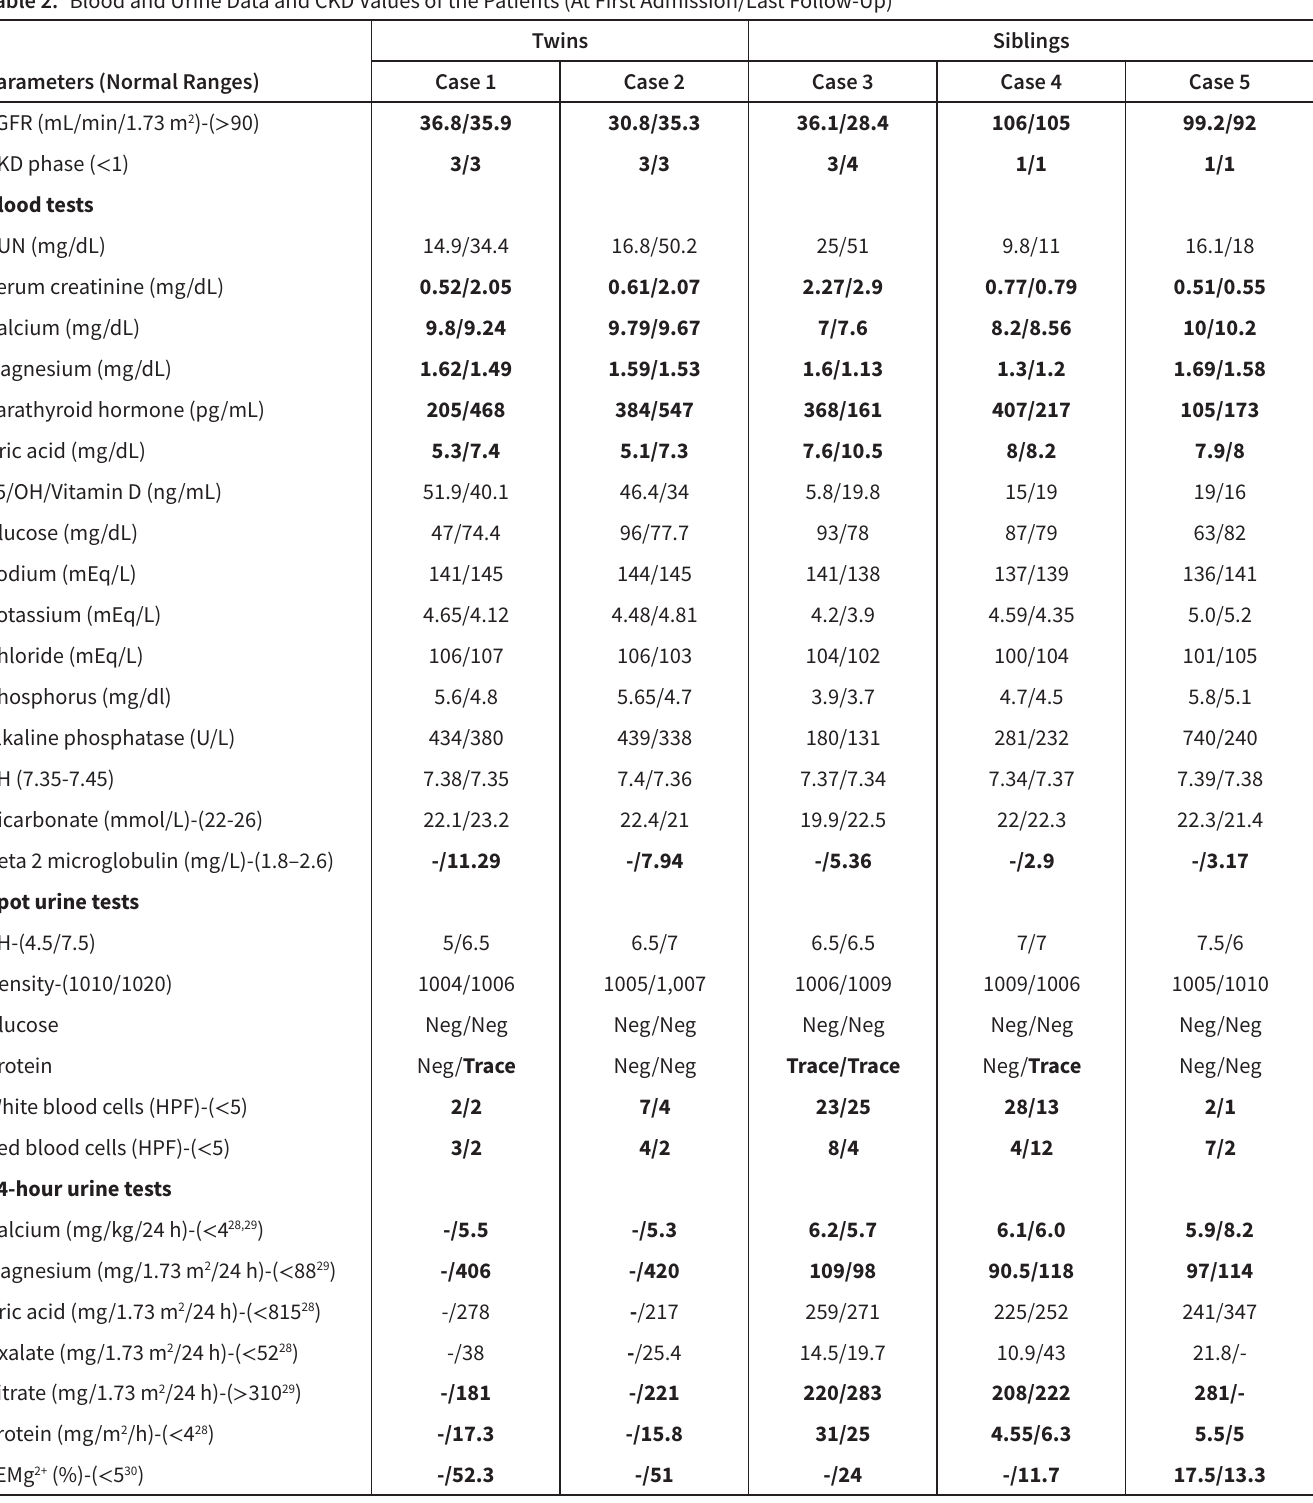
Table 2. Blood and Urine Data and CKD Values of the Patients (At First Admission/Last Follow-Up)